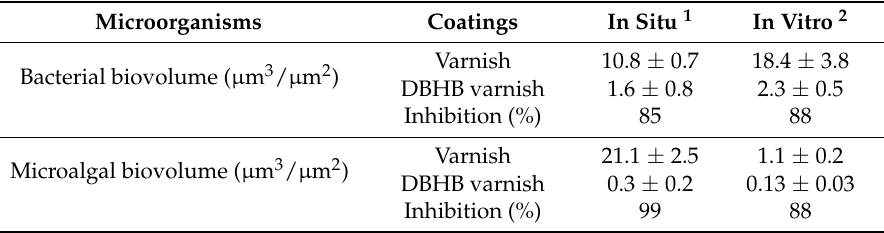
Table 2. Comparison of bacterial and microalgae biovolumes developed on coatings during in situ and in vitro experiments.